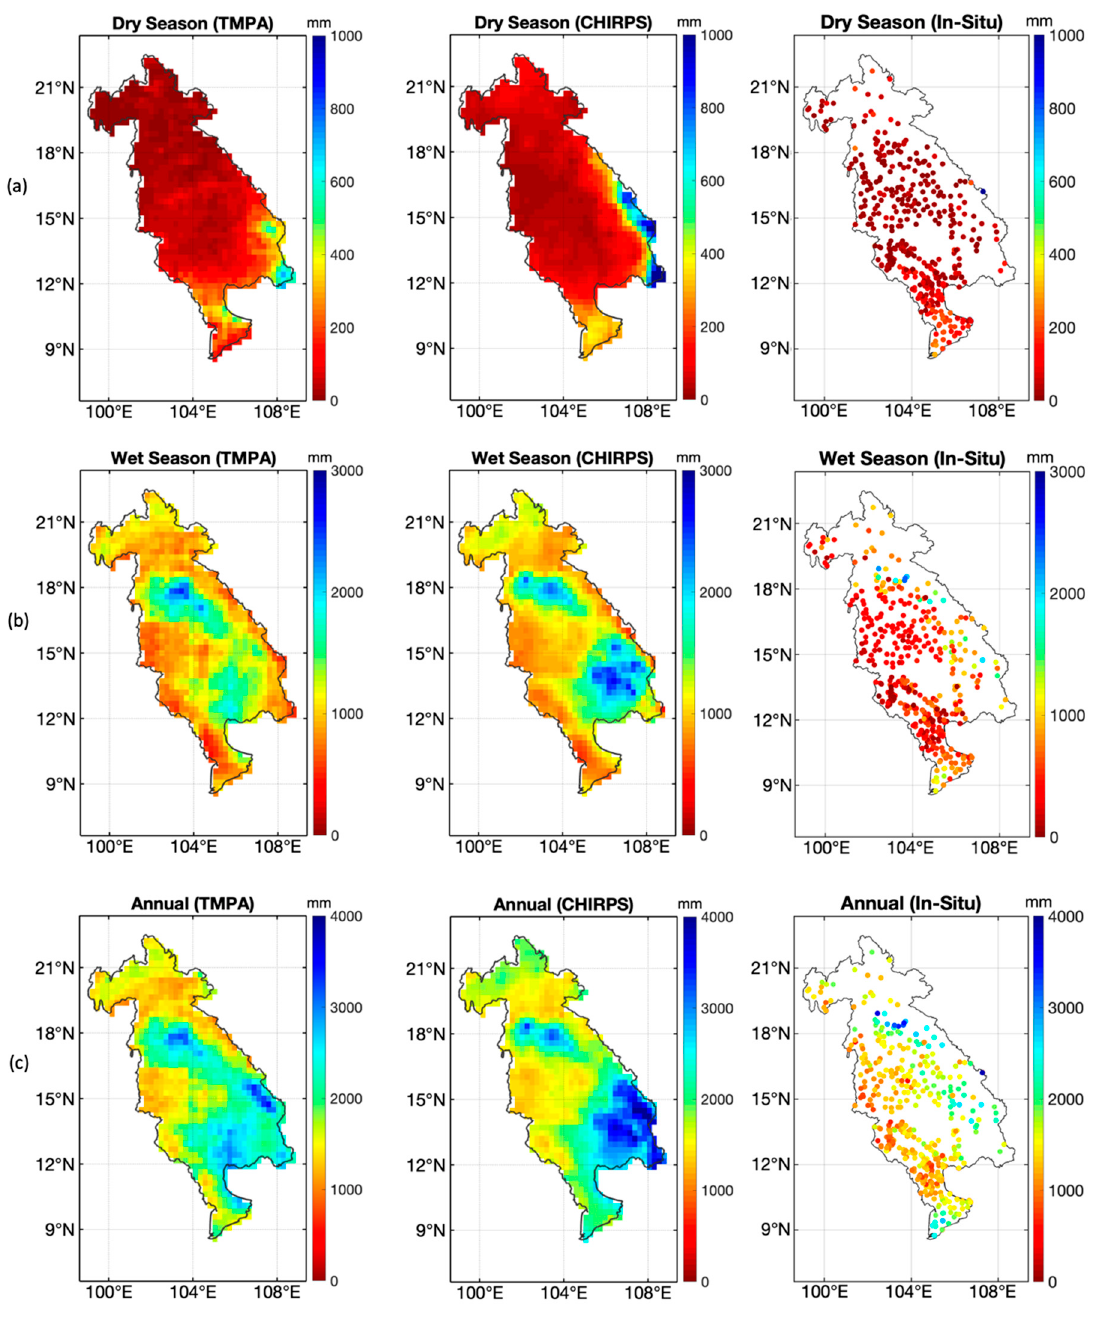
Figure 3. Rainfall Distribution in Lower Mekong River Basin. ( a ) Average (average over 2000 to 2014) seasonal rainfall accumulation during the dry season (November to February) for Tropical Rainfall Measuring Mission (TRMM) Multi-Satellite Precipitation Analysis (TMPA), Climate Hazards Group InfraRed Precipitation with Station (CHIRPS), and in-situ. ( b ) Average seasonal rainfall accumulation during the wet season (June to September) for TMPA, CHIRPS, and in-situ. ( c ) Average annual rainfall accumulation for TMPA, CHIRPS, and